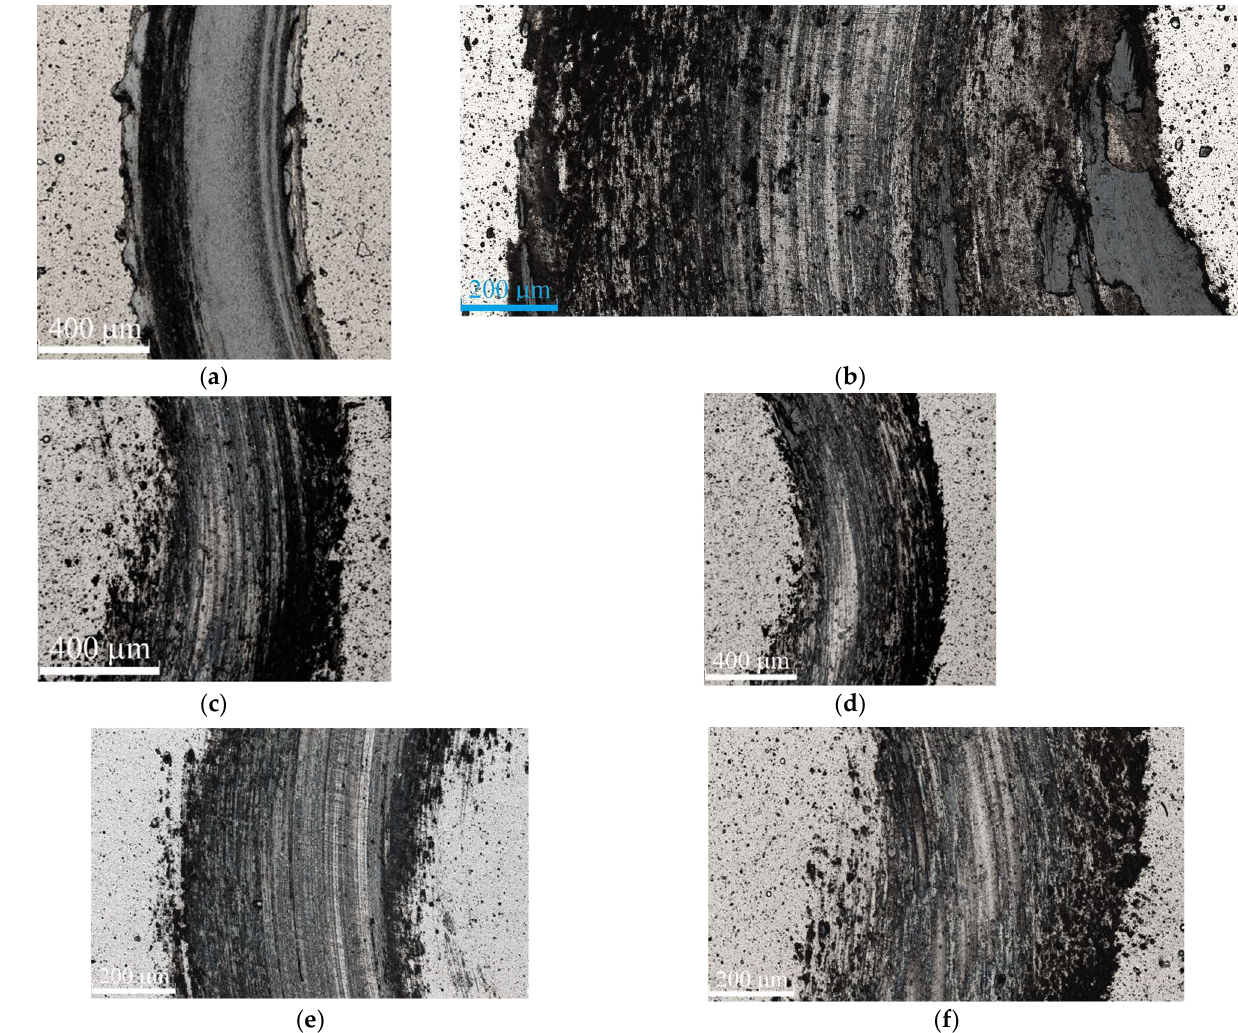
Figure 8. Optical images of wear tracks on ZrN ( a ), CrN ( b ), ZrCrN(0.5) ( c ), ZrCrN(3.5) ( d ), ZrCrN(5) ( e ) and ZrCrN(8) ( f ) after sliding at 6Н.